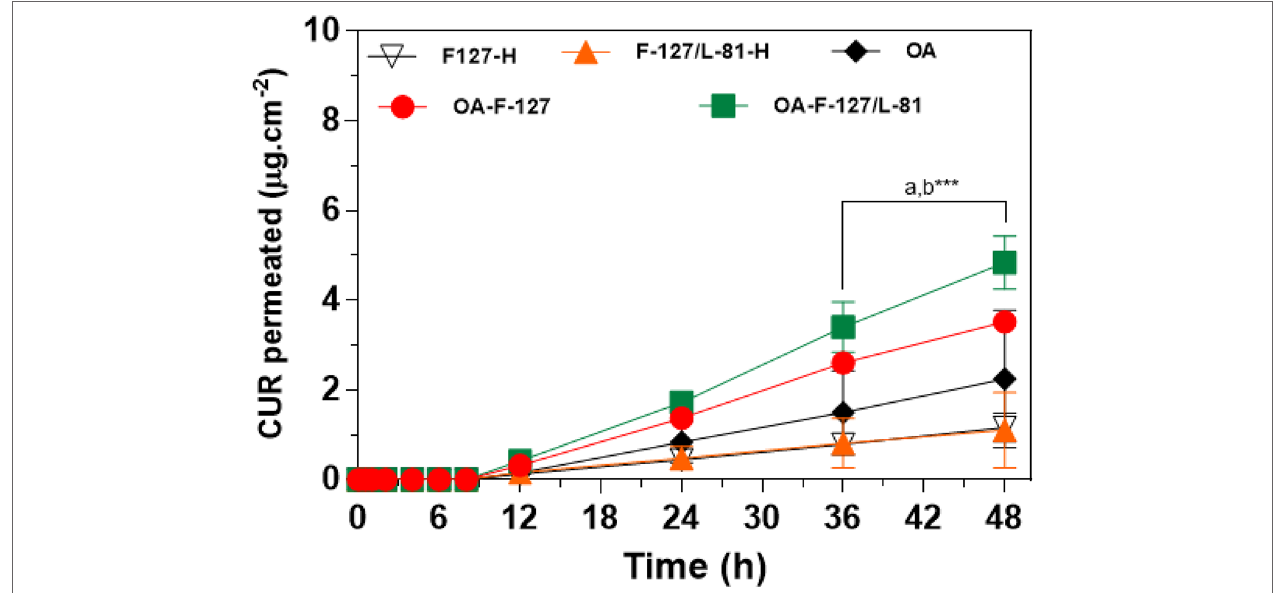
FIGURE 4 | Curcumin (CUR) permeation profiles from formulations across Strat-M ® artificial membranes (mean ± standard deviation, n = 4–6). Organogels formulations containing 0.1% CUR. OA, oleic acid; PL F-127, Pluronic ® F-127; PL L-81, Pluronic ® L-81; CUR, curcumin. H—indicates hydrogels formulations (without oleic acid). a- OA-F-127/L-81 vs . F-127/L-81-H (PL-F-127-H; b- OA-F-127/L-81 vs . OA-F-127. ***p <